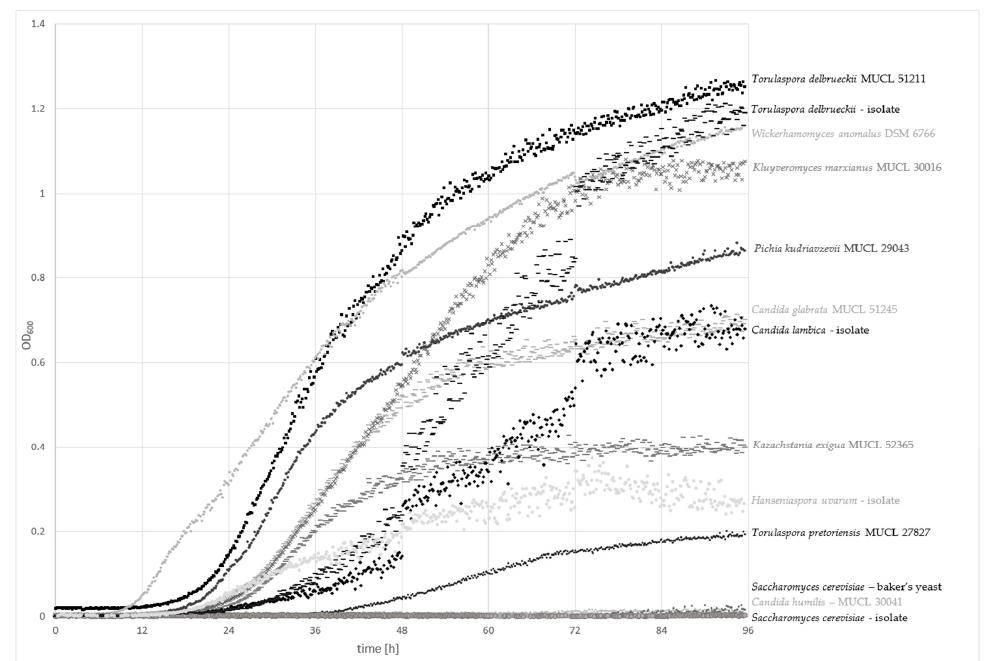
Figure 1. Measurement of the optical density at 600 nm (OD 600 ) over 96 h of incubation at 25 °C to indicate the growth rate of sourdough-relevant yeasts in a model medium containing mono-/di-/trisaccharides, and fructans, according to the average concentrations found in 20 Austrian wheat varieties (Table 1).